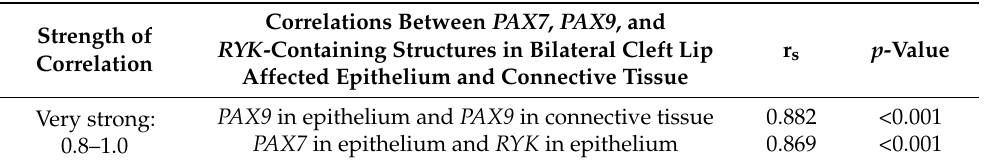
Table 3. Correlations between paired box 7 ( PAX7 ), paired box 9 ( PAX9 ), and receptor-like tyrosine kinase ( RYK ) immunopositive structures in bilateral cleft lip affected tissue based on Spearman’s rank correlation coefficient calculation (r s —Spearman’s rho value).